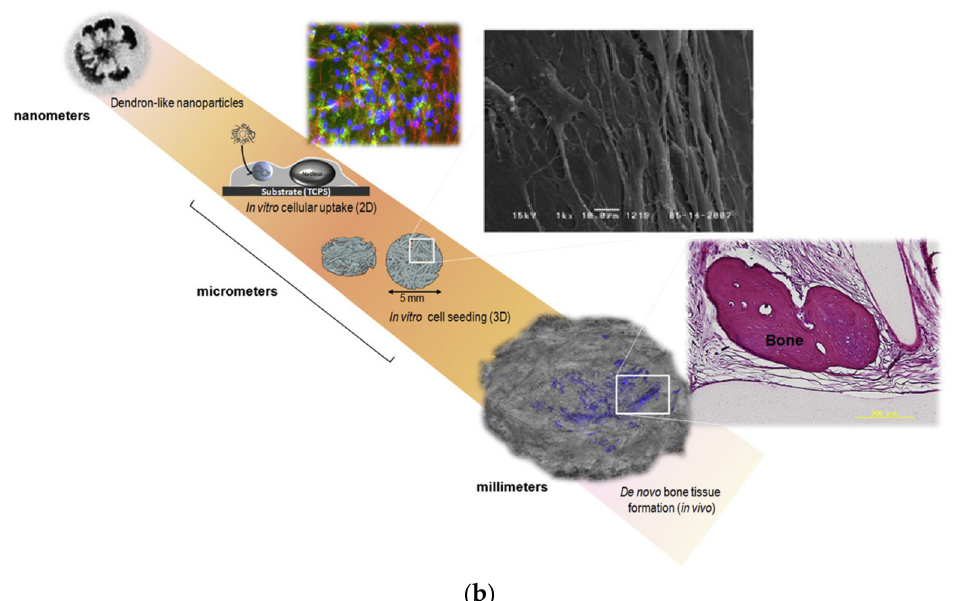
Figure 16. ( a ) Schematic illustration of the synthesis of conjugated PAMAM derivatives and their effects on the differentiation of human adipose-derived mesenchymal stem cells. Reproduced with permission from [185]. Copyright: Elsevier B.V. ( b ) Schematic illustration of ex vivo stem cells “tune-up” and de novo bone tissue formation in vivo. Dendronlike NPs are internalized by stem cells in vitro, and then cells are seeded onto starch-polycaprolactone scaffolds and implanted. Release of dexamethasone to the cytoplasm will occur and de novo bone formation (blue areas) is observed within SPCL scaffolds after 4 weeks of implantation. Reproduced with permission from [190]. Copyright: Elsevier Inc.